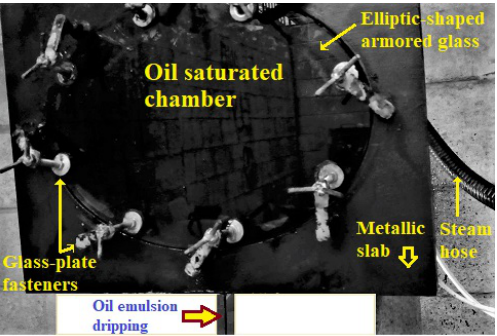
Figure 5. Picture of the oil-saturated chamber 15 min after the injection start-up. Notice the dripping of the oil emulsion in the lower